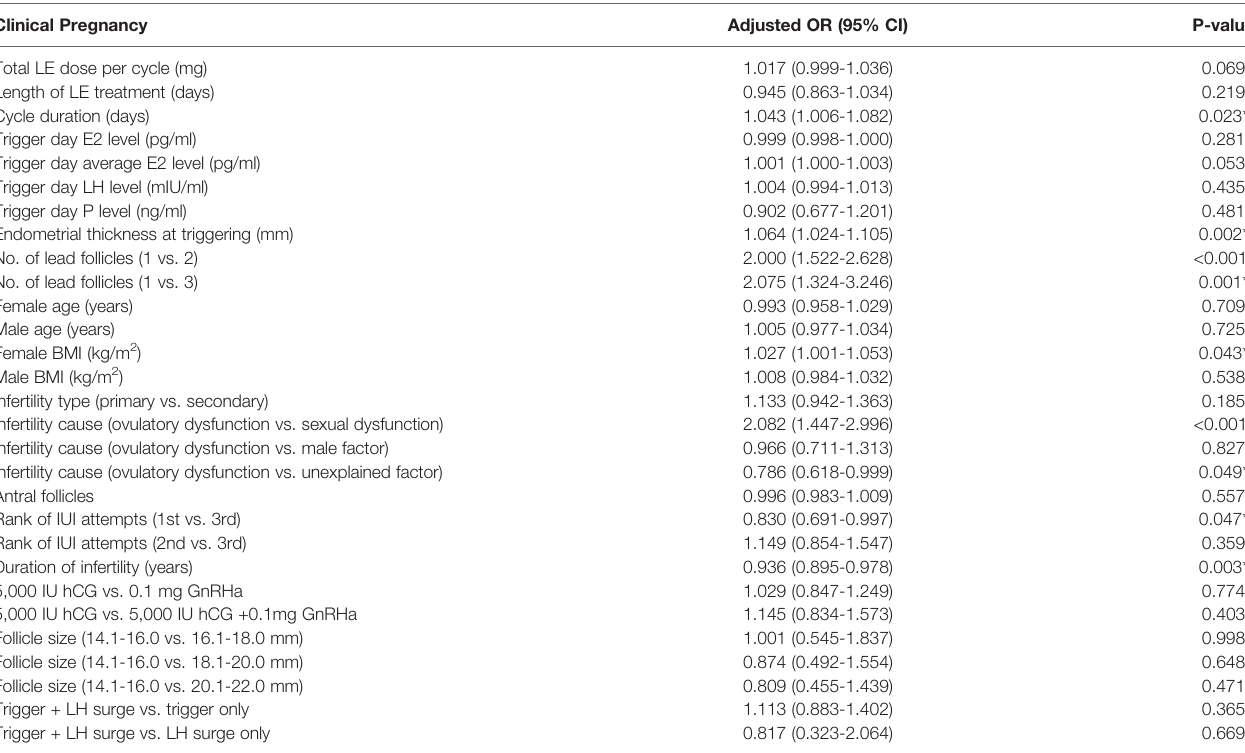
TABLE 4 | Binary logistic regression to account for variables associated with clinical pregnancies after undergoing LE ovulation induction with IUI (n=6,285). Clinical